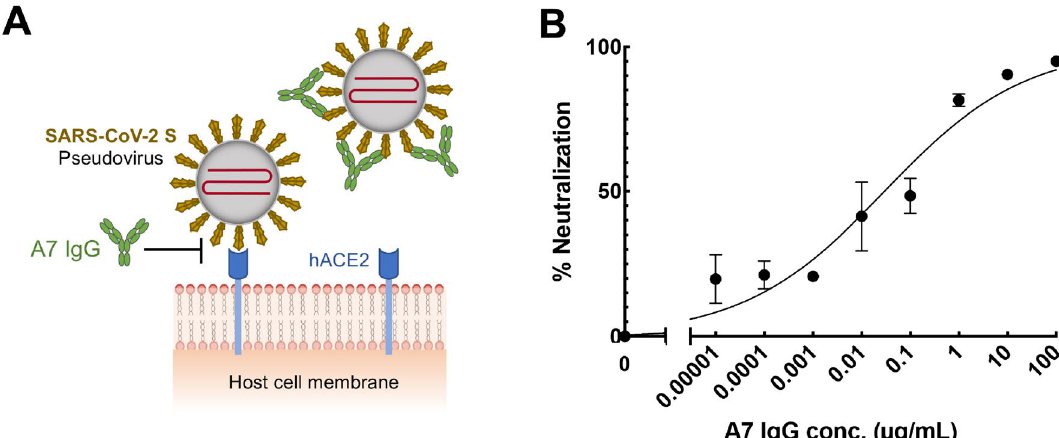
Figure 6. Neutralization of SARS-CoV-2 pseudovirus by A7 IgG. ( A ) Scheme and ( B ) results of neutralization of pseudovirus infection by A7 IgG. n = 3; Data have been expressed as mean ± standard